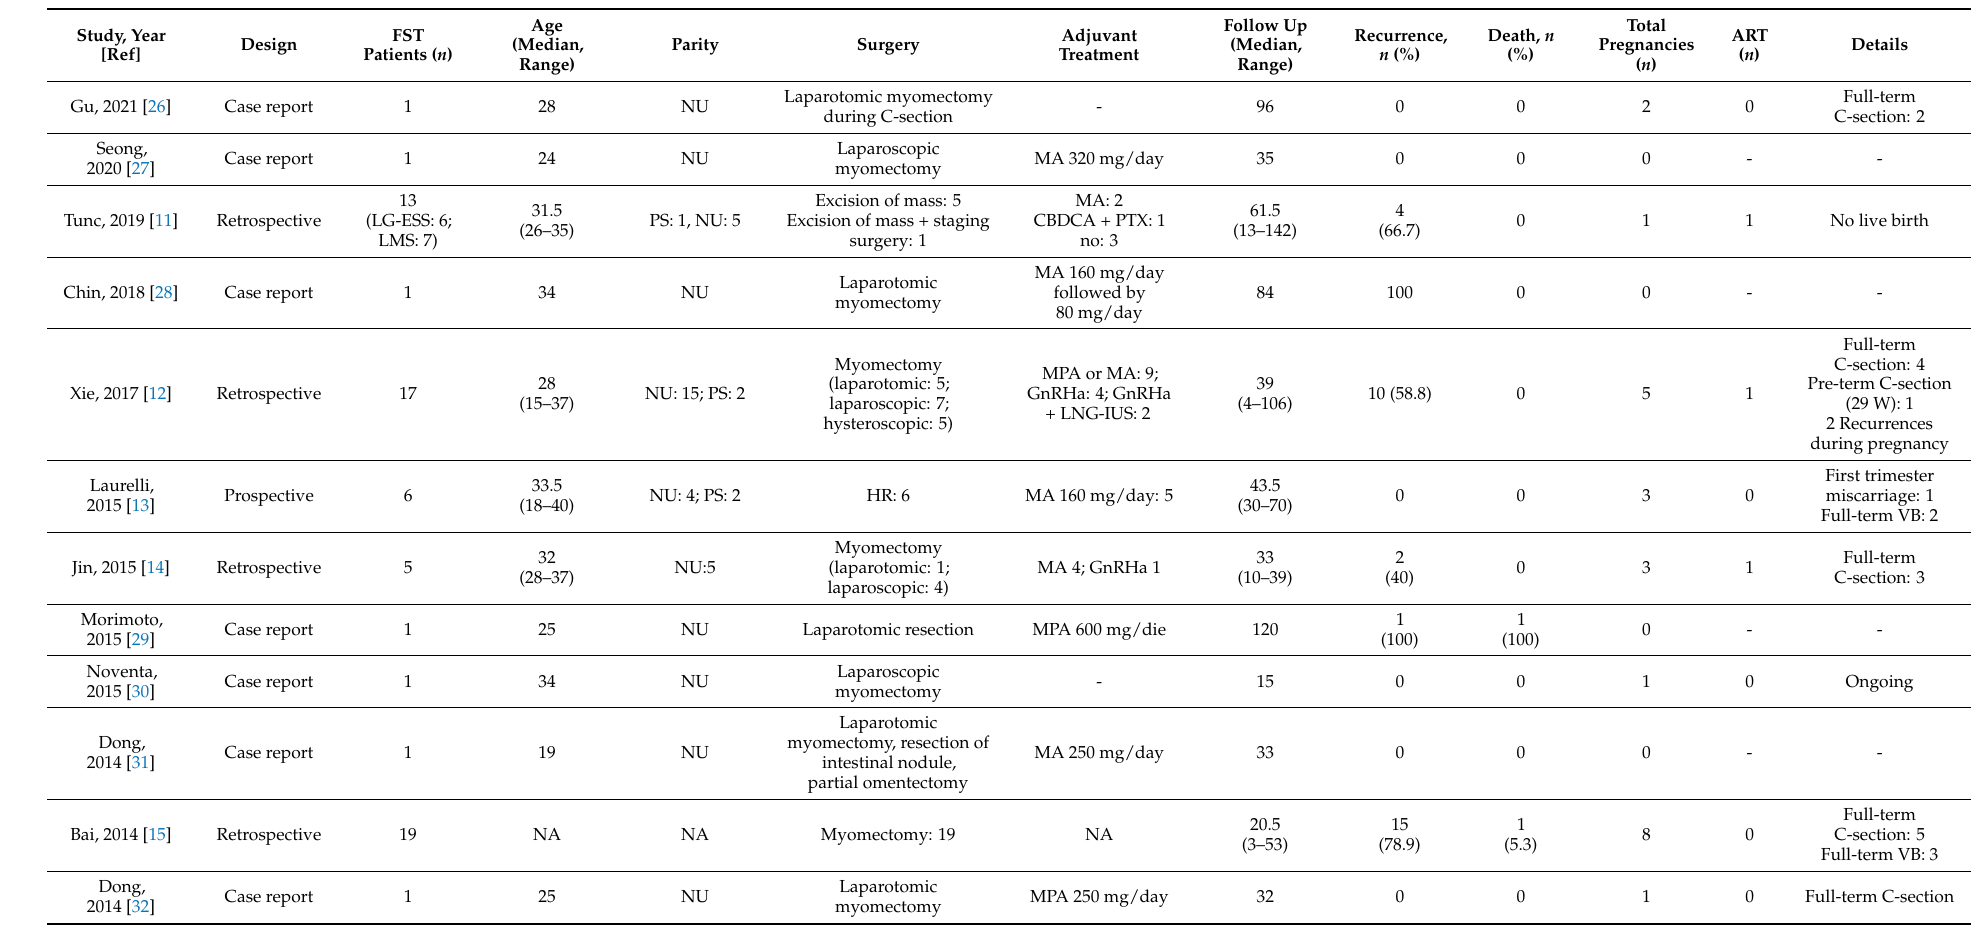
Table 3. Published reproductive and oncologic outcomes after FST of